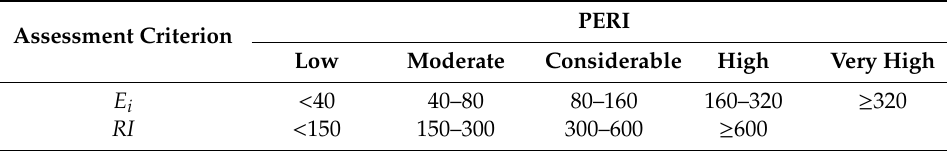
Table 1. Classification of potential ecological risk index